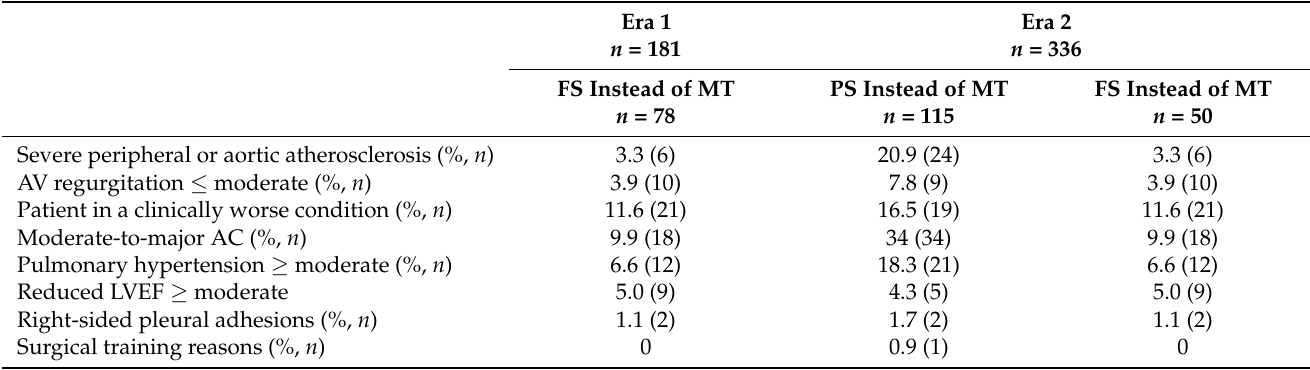
Table 1. Reasons against MT and PS access.